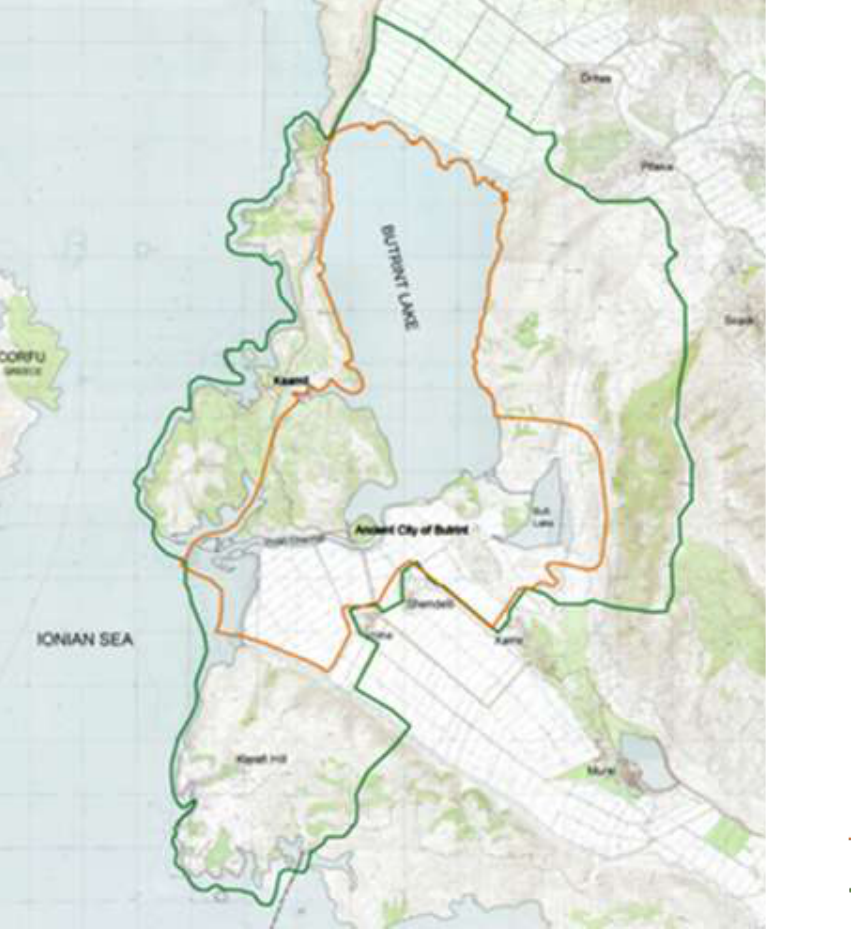
Figure 4: Possible expansion of the WHS to cover the whole of Lake